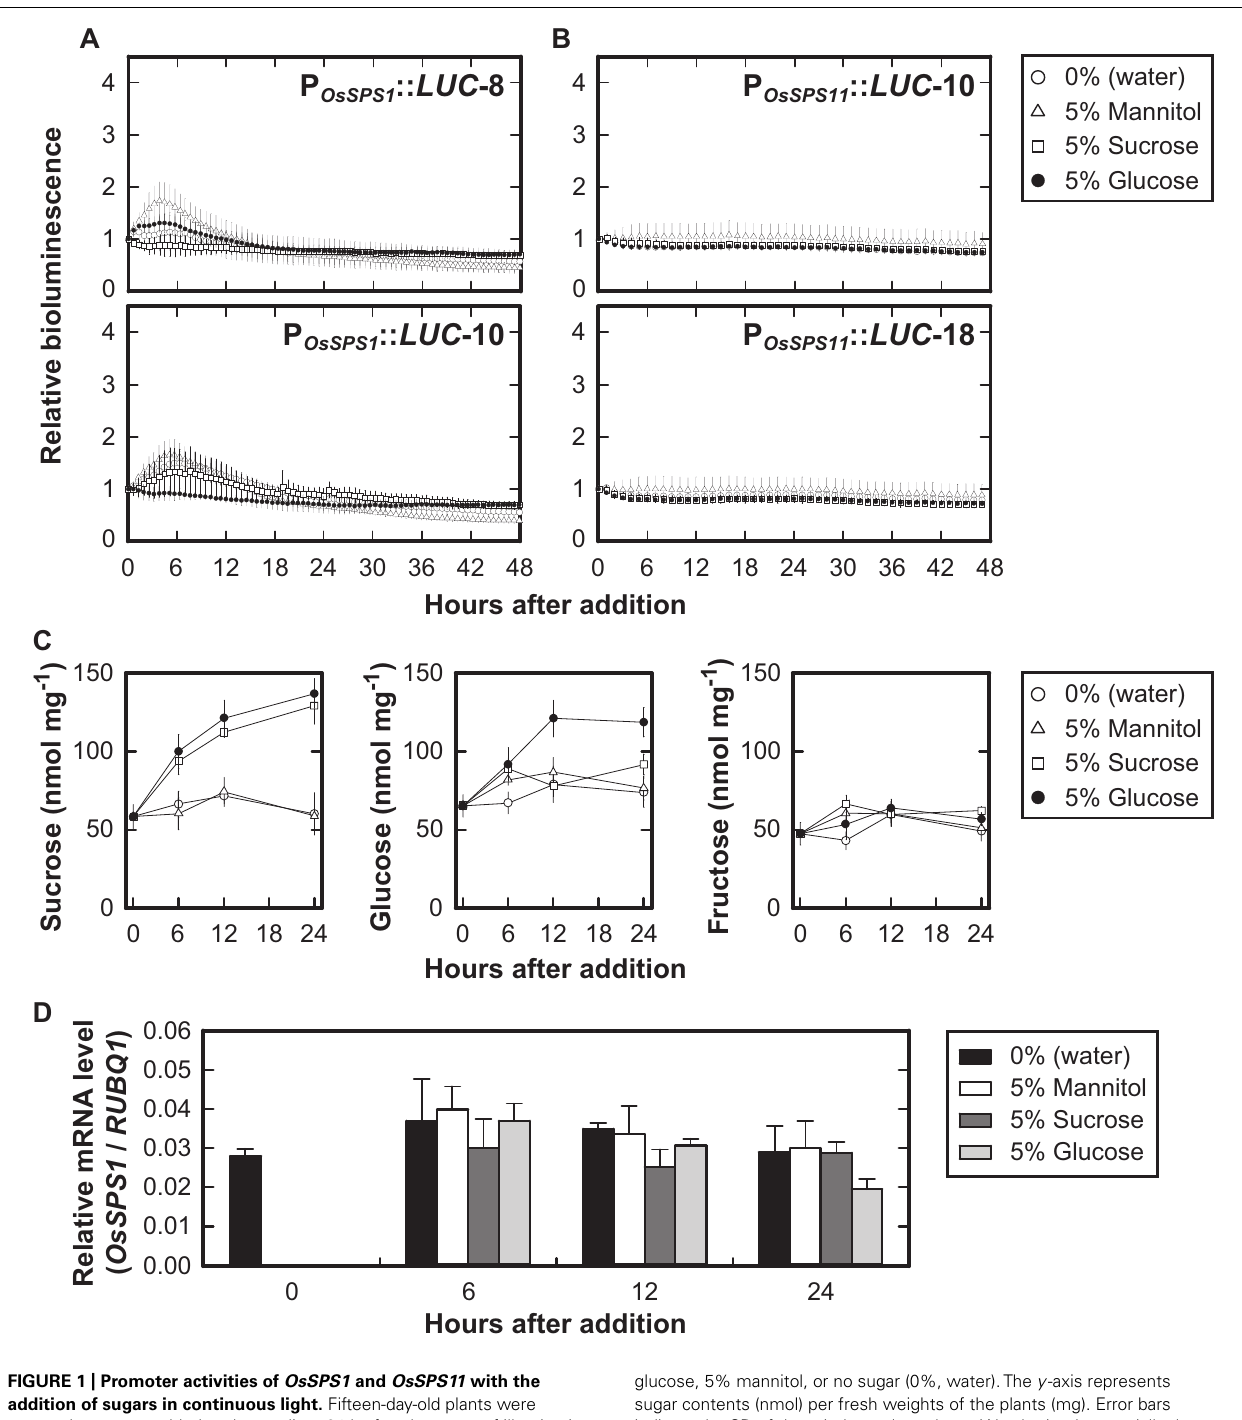
FIGURE 1 | Promoter activities of OsSPS1 and OsSPS11 with the addition of sugars in continuous light. Fifteen-day-old plants were exposed to sugars added to the medium 24 h after the onset of illumination. (A) Bioluminescence of P OsSPS 1 :: LUC reporter plants without resetting the circadian clock. Data points indicate the mean ± SD of four independent plants in each line.We obtained essentially the same results from three independent experiments. (B) Bioluminescence of P OsSPS 11 :: LUC reporter plants. Data points indicate the mean ± SD of five independent plants in each line.We obtained essentially the same results from three independent experiments. (C) Endogenous sugar contents of wild-type (non-transgenic) plants after an exogenous supply of 5% sucrose, 5%